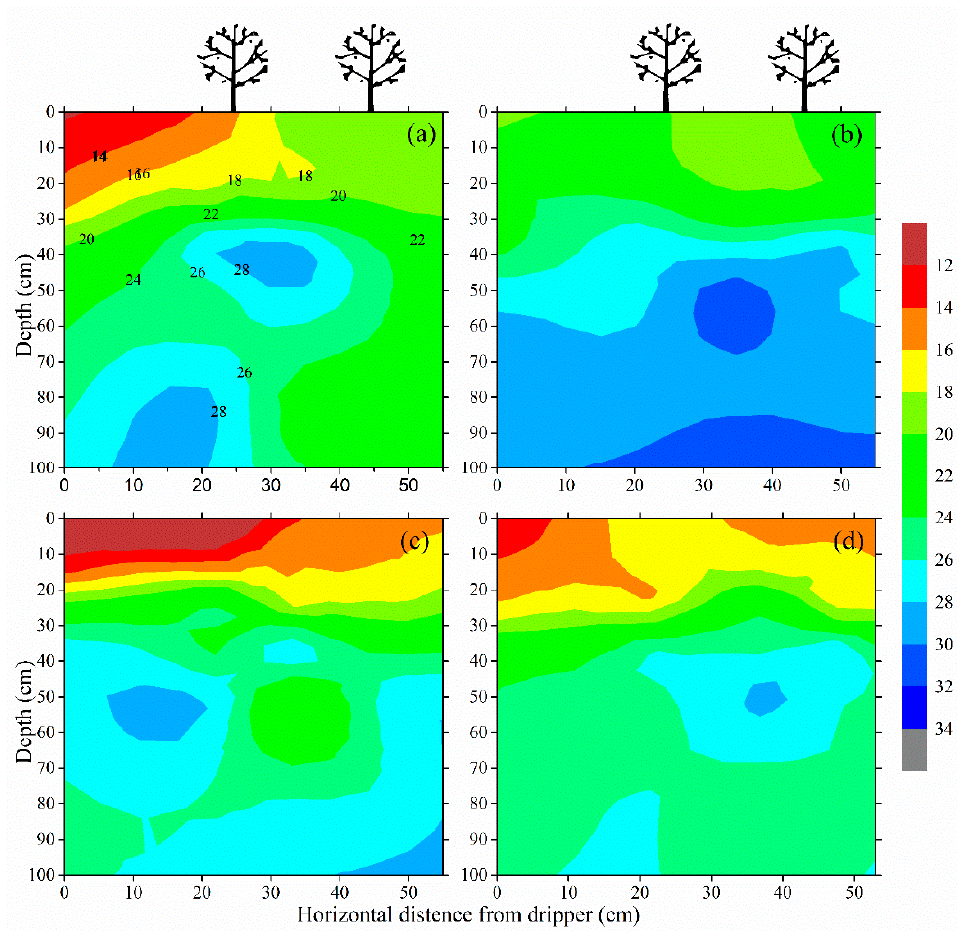
Figure 6. Vertical distribution of soil water content (%, by mass) under mulched drip irrigation on ( a ) 20 June, ( b ) 23 June, ( c ) 30 June, ( d ) 8 July 2016.